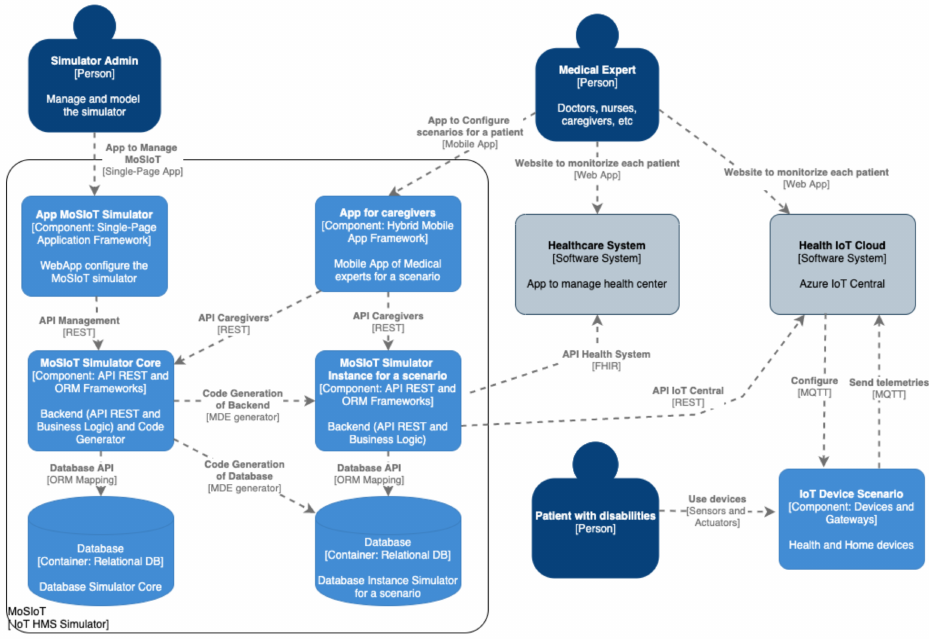
Figure 2. C4 Software architecture of the MoSIoT